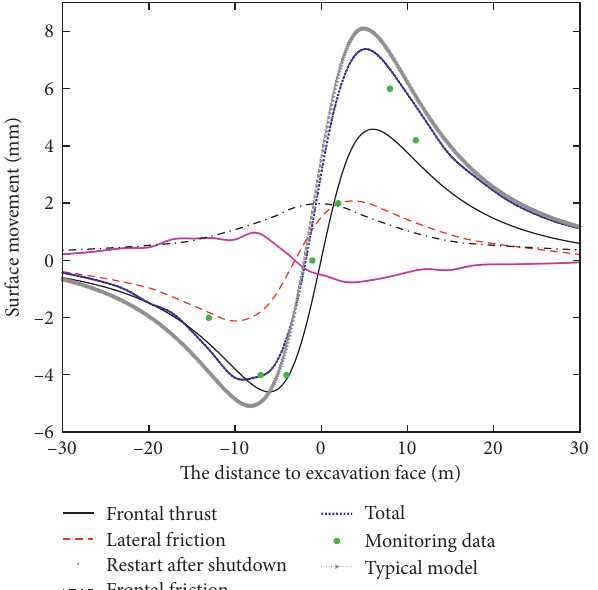
Figure 9: Lateral soil settlement curves at different depths ( x � −